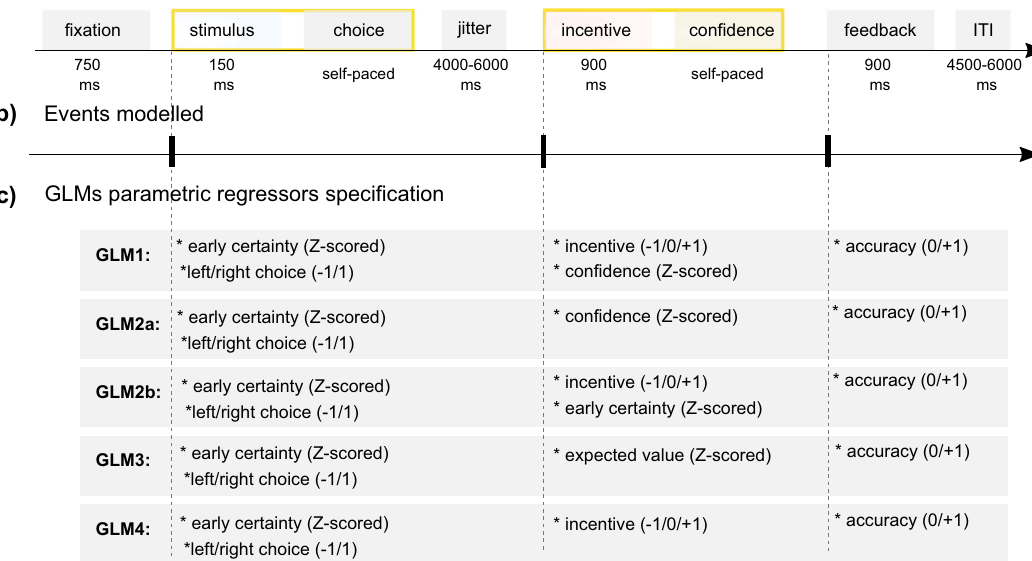
Fig. 2 Overview of general linear models for fMRI analyses. a – b Events of interest. The timeline depicts the succession of events within a trial. a Yellow boxes highlight the two events/timing of interest (stimulus/choice and incentive/con fi dence), that are modeled as stick function for the functional magnetic resonance imaging (fMRI) analysis. We also modeled the feedback event as a stick function. c General linear models (GLMs) parametric regressors speci fi cation. The graph displays the different combinations of parametric modulators of each event of interest for all GLMs used to analyze the fMRI data.